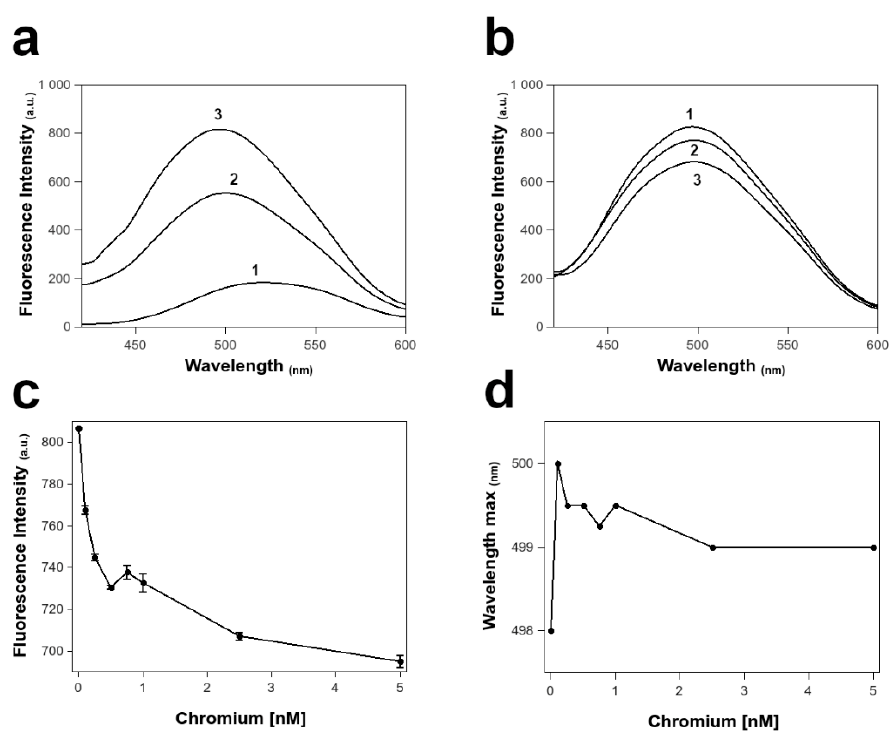
Figure 8. ANS-PLs fluorescence analysis. ( a ) Spectra of ANS fluorescence emission alone (1) and in presence of PLs at (2) 0.01 mg/mL and (3) 0.02 mg/mL. ( b ) Spectra of ANS fluorescence emission in presence of PLs at increasing concentration of chromium (VI) (1 = 1 nM, 2 = 10 nM, 3 = 100 nM). ( c ) Plot of the maximum fluorescence intensity values of ANS in presence of PLs at increasing concentration of chromium (VI) in the range from 0 to 5 nM. ( d ) Plot of the maximum fluorescence emission wavelength of ANS in presence of PLs at increasing concentration of chromium (VI) in the range from 0 to 5 nM. All measurements in ( c , d ) were performed at least three times at room